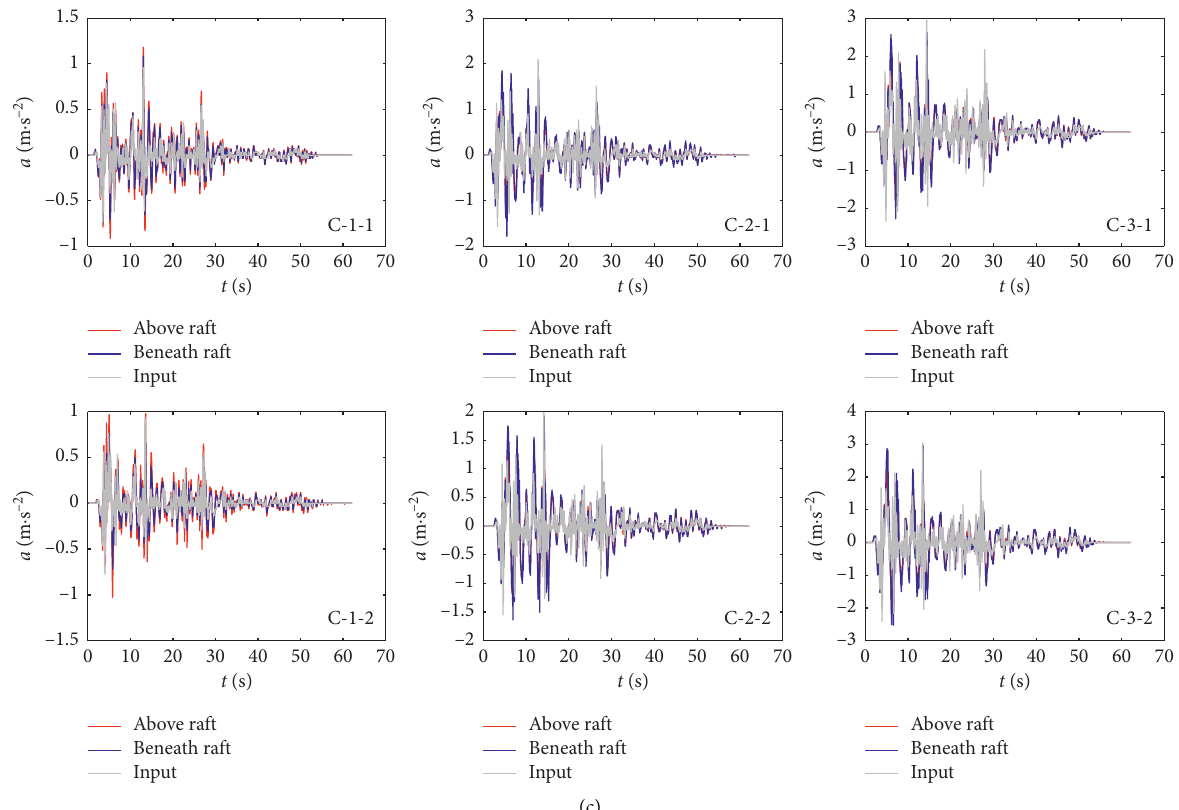
Figure 8: Acceleration time histories of the clay layer and gravel cushion. (a) Single-sized aggregate gravel cushion. (b) Two-sized aggregate gravel cushion. (c) Continuously graded aggregate gravel